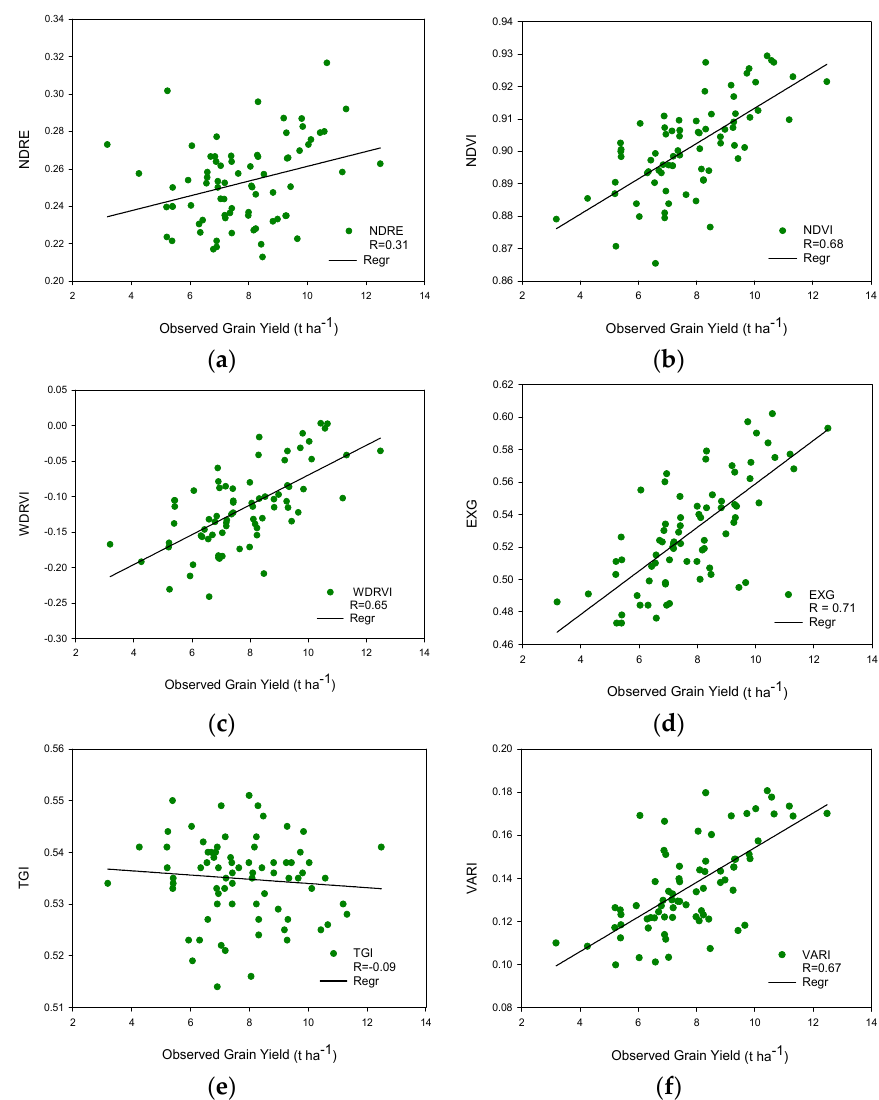
Figure 6. Correlation of vegetation indices and yield for 79 DAS for corn crops. ( a ) Normalized difference red edge index (NDRE); ( b ) normalized difference vegetation index (NDVI); ( c ) wide dynamic range vegetation index (WDRVI); ( d ) excess green (ExG); ( e ) triangular greenness index (TGI); ( f ) visible atmospherically resistant index (VARI).